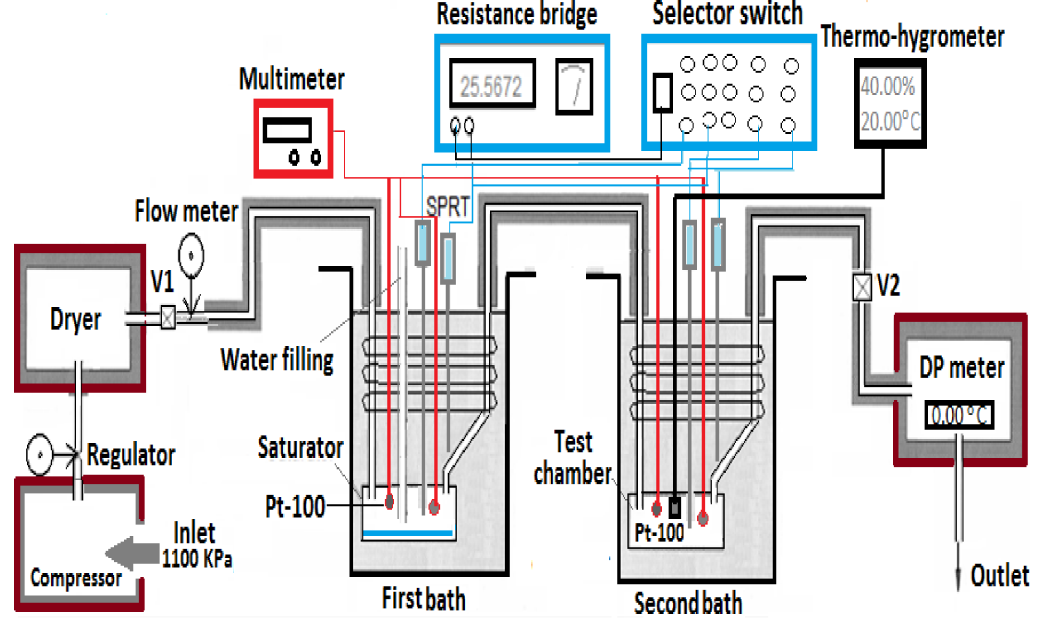
Fig. 1. Schematic diagram of the two-temperature